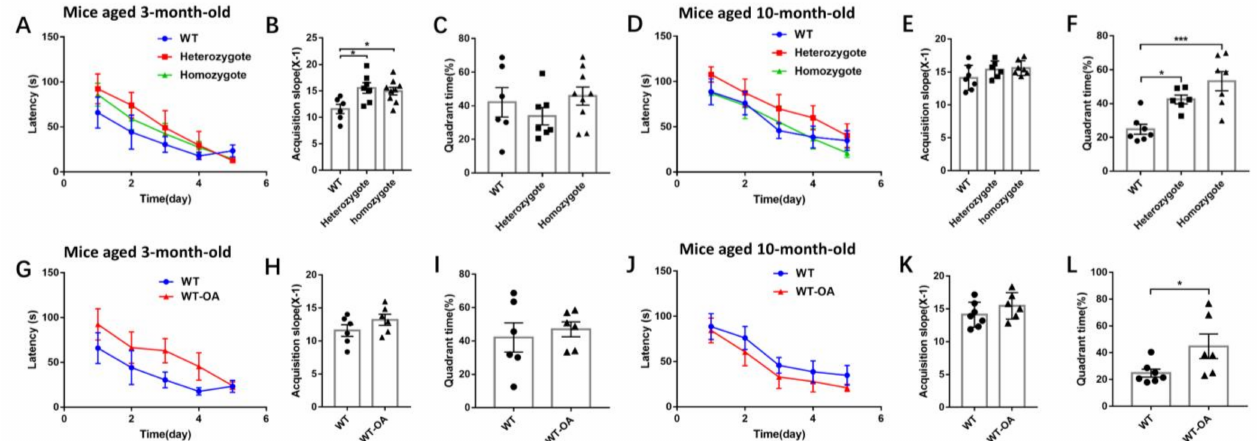
Figure 6. BChE KO and (R)-bambuterol administered mice enhanced the age-related spatial memory using a water maze test. ( A – C ) The latency before the successful access to the platform on days 1–5 (the acquisition training), the slope of the latency from day 1 to 5, and the platform quadrant time on day 6 (the probe test) of 3-month-old BChE KO mice. ( D – F ) The latency before successful access to the platform on days 1–5, the slope of the latency from day 1 to 5, and the platform quadrant time on day 6 of 10-month-old BChE KO mice. ( G – I ) The latency before successful access to the platform on days 1–5, the slope of the latency from day 1 to 5, and the platform quadrant time on day 6 of 3-month-old ( R )-bambuterol administered mice. ( J – L ) The latency before successful access to the platform on days 1–5, the slope of the latency from day 1 to 5, and the platform quadrant time on day 6 of 10-month-old ( R )-bambuterol administered mice. Data were shown as mean ± SEM. n = 6–9 mice per group. * p < 0.05; *** p < 0.001, one-way ANOVA followed by Tukey’s post hoc test (for B , C , E , F ) and unpaired t test (for H , I , K , L